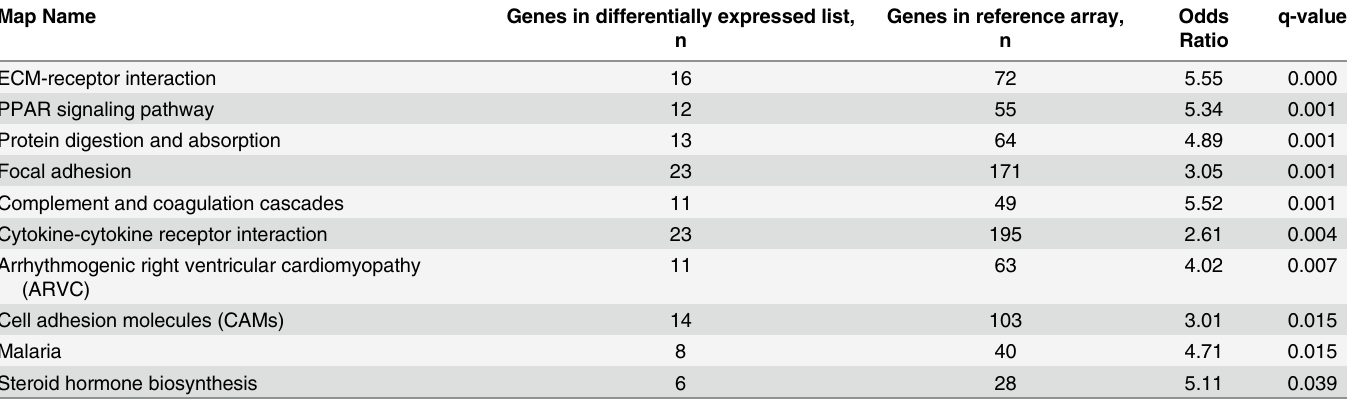
Table 4. A list of the 10 KEGG pathways that were significant in the comparison between visceral and subcutaneous adipose tissues of pregnant women. Map Name